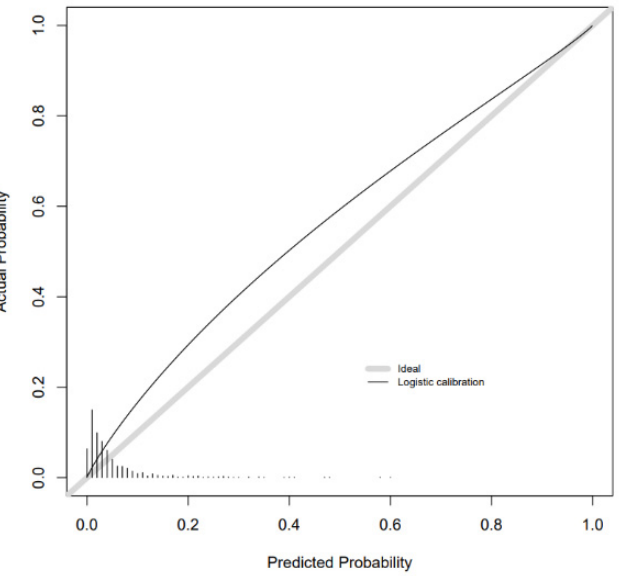
Figure 2. Calibration slope for GDM combined model in BiB 1000 testing sample.